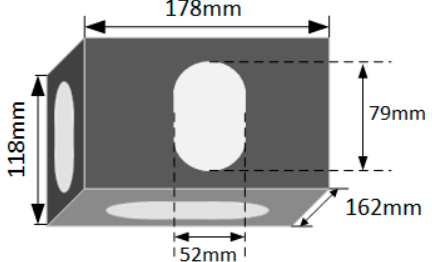
Figure 8. Standard container corner